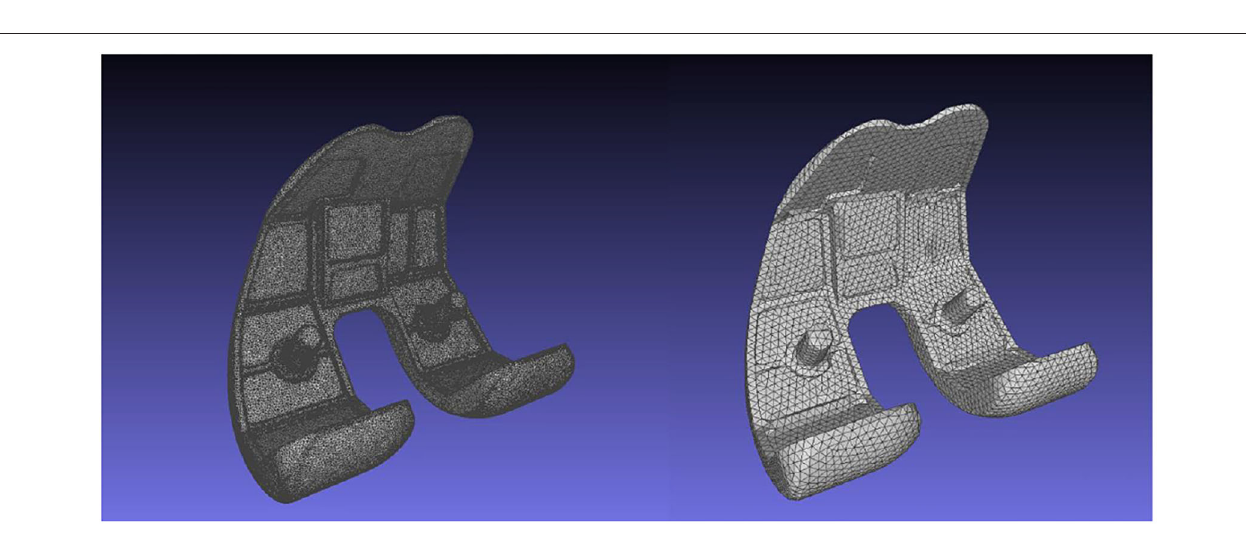
an XML (FEB) file including all the characteristics that a FEM representing an instrumented knee joint